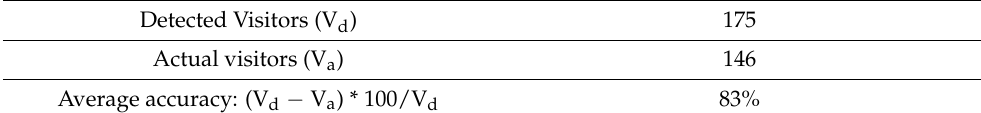
Table 2. Summary of results, including average accuracy.